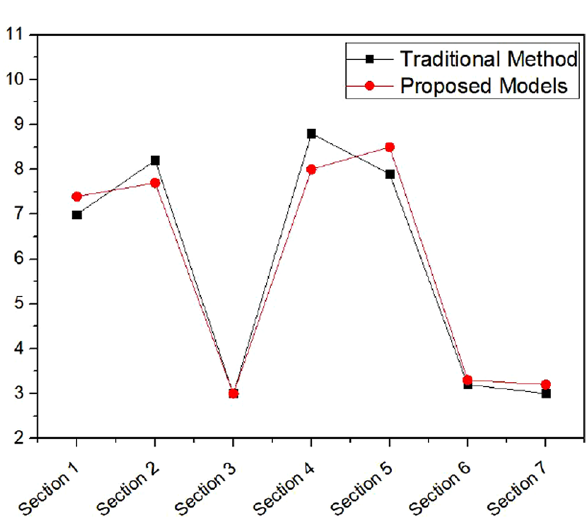
Figure 10. RRS results of traditional method versus proposed models.